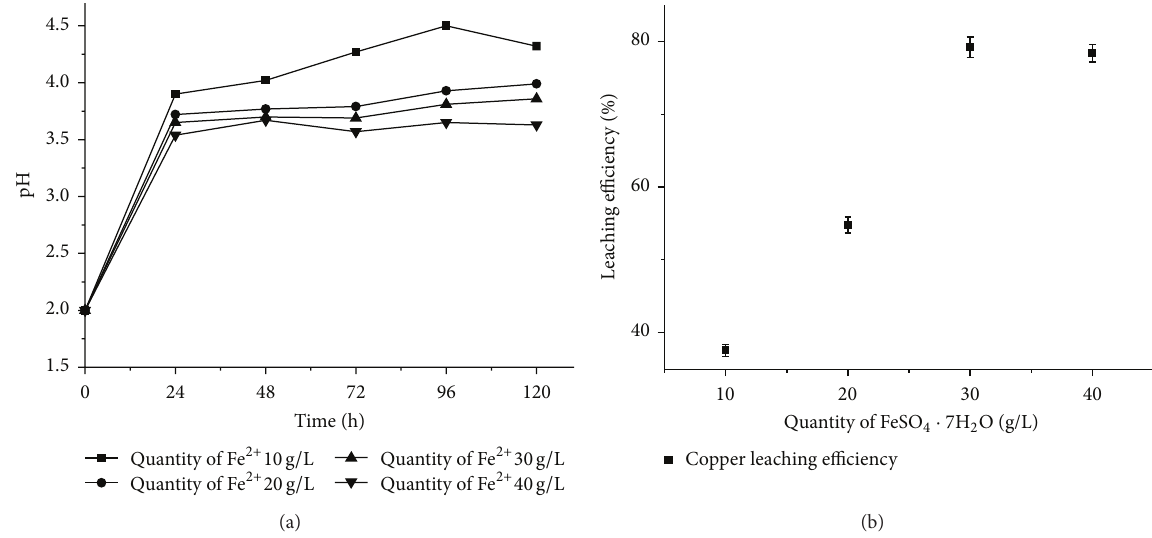
Figure 7: Different FeSO 4 ⋅ 7H 2 O quantity and medium pH changed with time (a) and 5 days leaching and copper leaching efficiency (b).